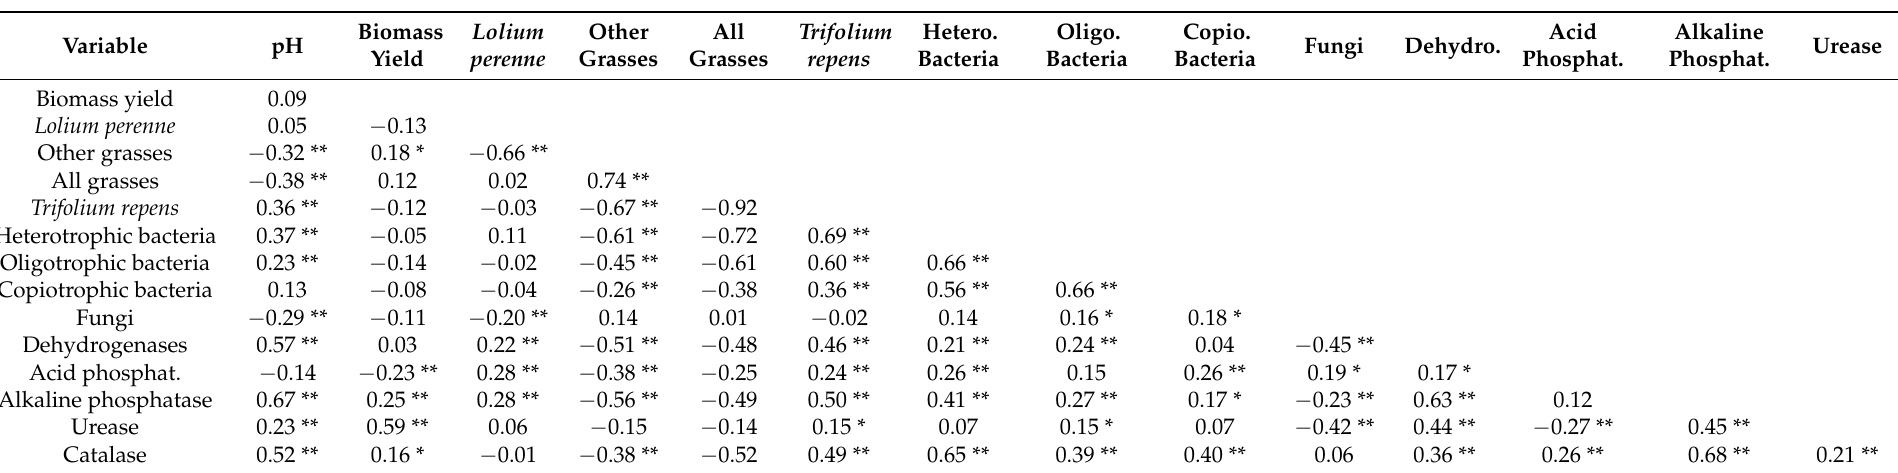
Table 5. Pearson’s correlation coefficient (r) for the examined parameters in 2018–2019 ( n =